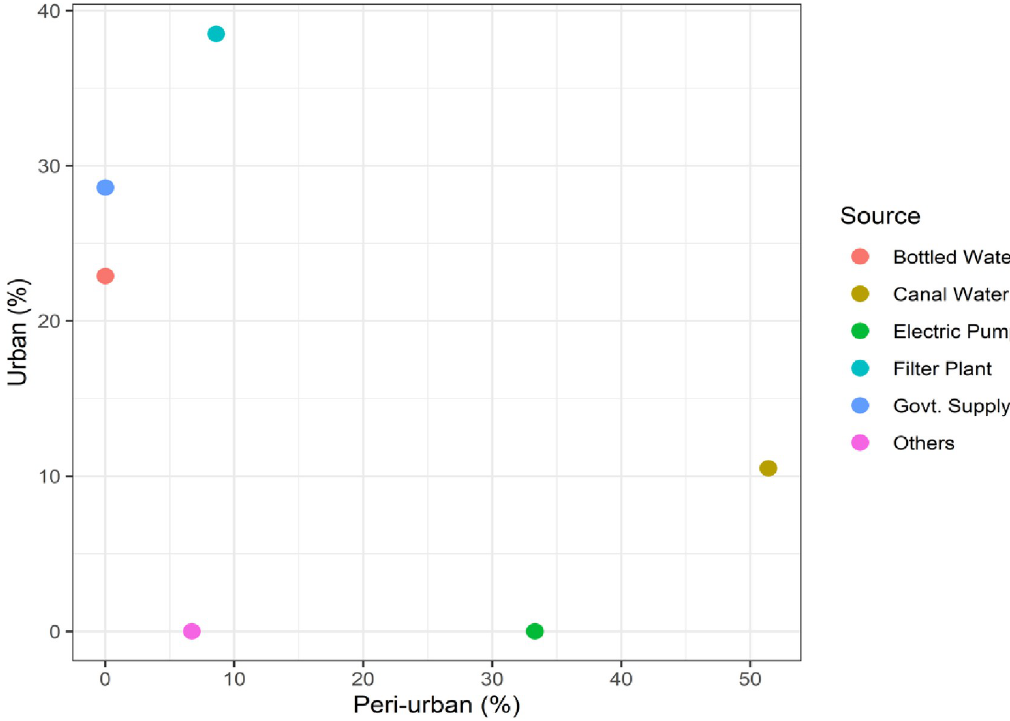
Fig 2. Distribution of drinking water sources of households among urban and peri-urban